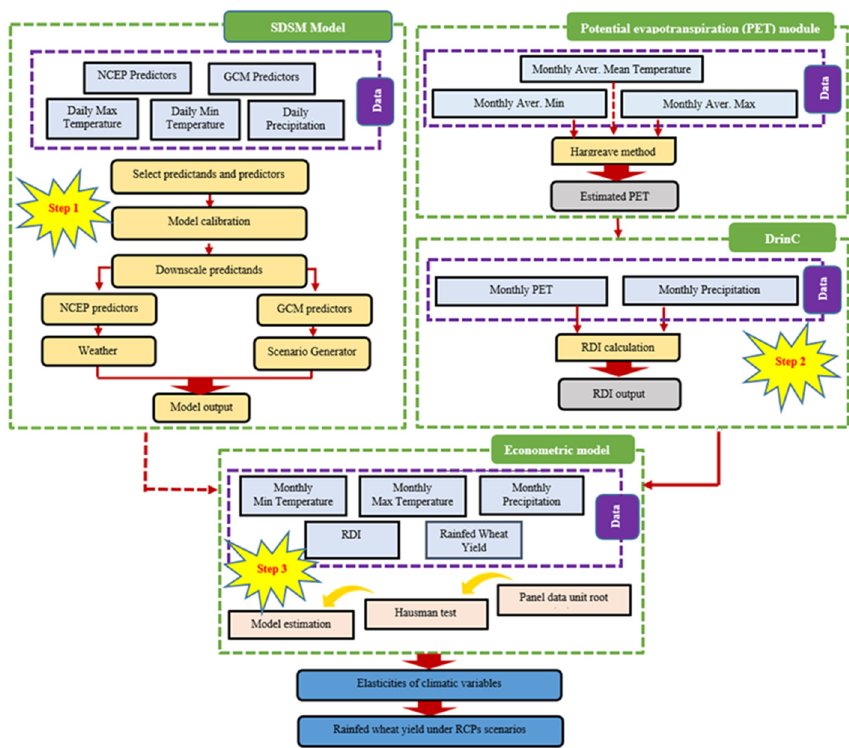
Figure 3. The framework of the applied methodology.